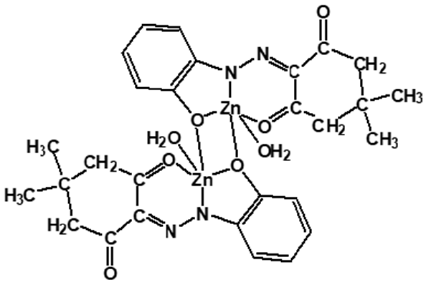
Figure 4. Zn(II)-AHBD catalyst (zinc(II) complex of an arylhydrazone of a β -diketone).